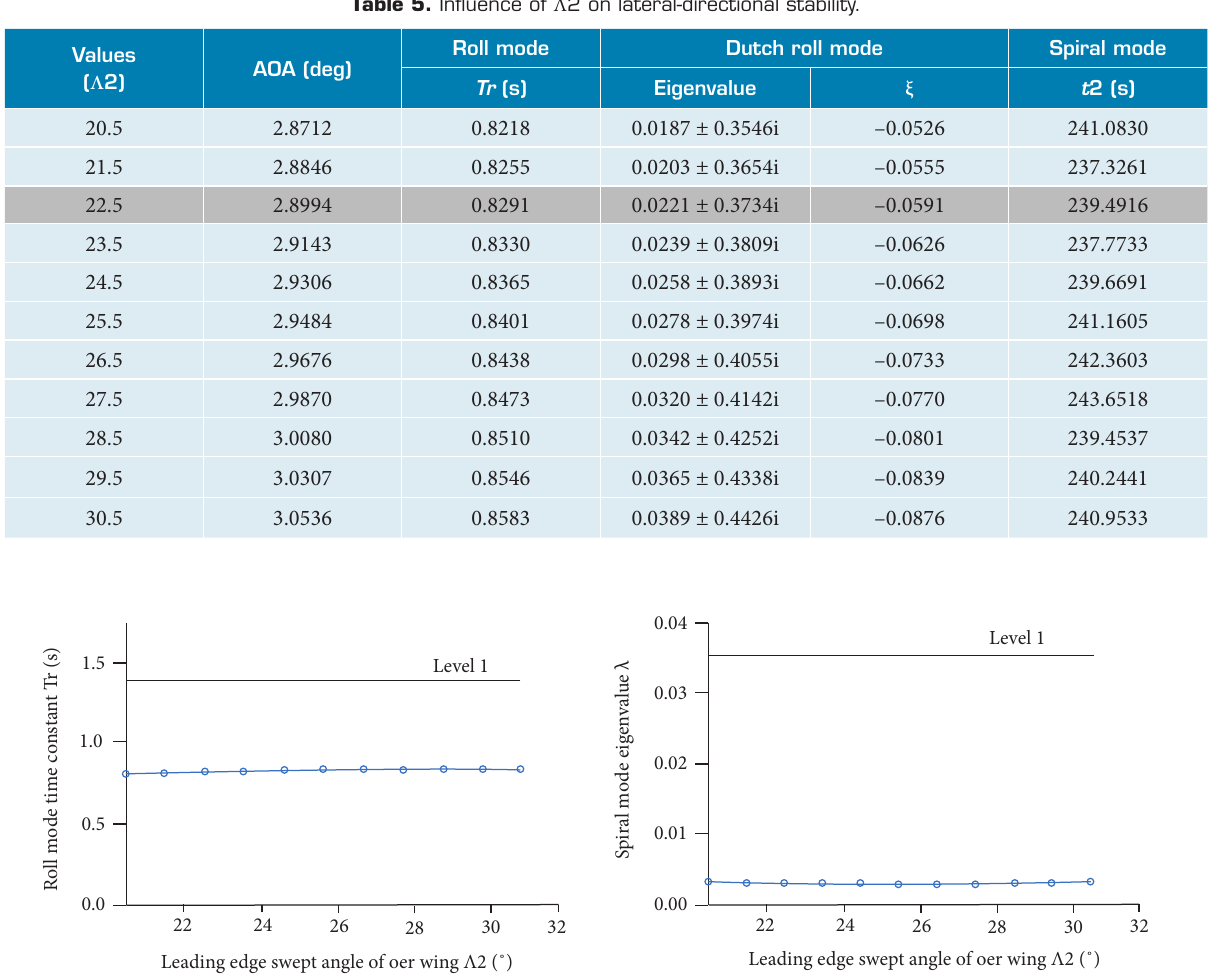
Figure 6. Influence of Λ 2 on roll mode and